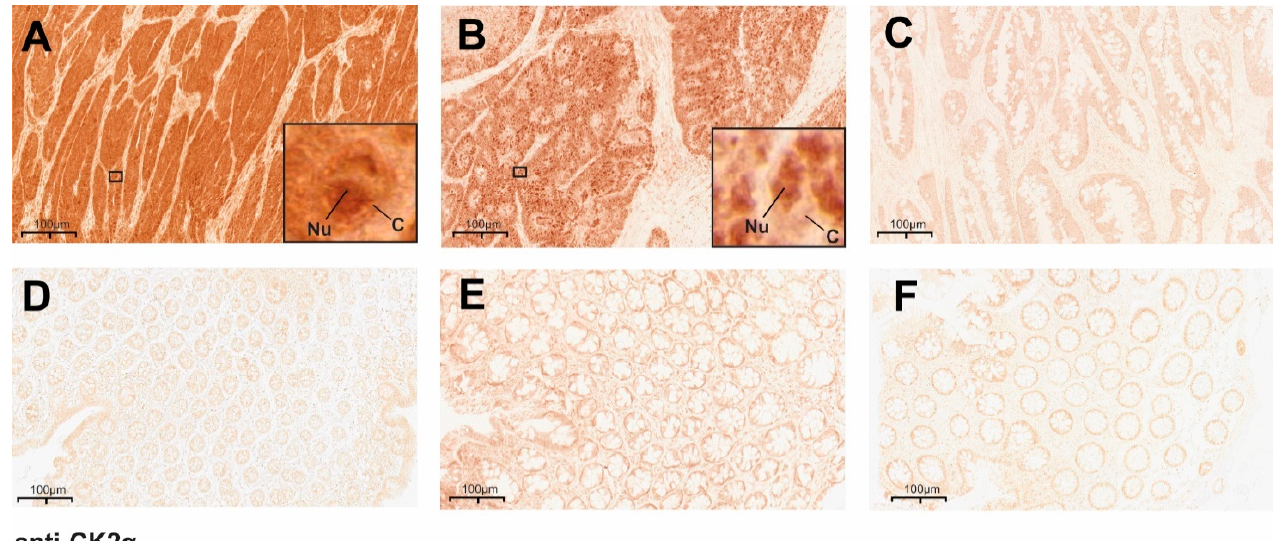
Figure 1. Immunohistochemical staining demonstrates significantly differential CK2 α expression in CRCs. Paraffin-embedded, invasively growing CRCs and corresponding surrounding normal mucosa was analyzed for CK2 α expression by immunohistochemical staining. Exemplarily shown are results of CK2 α expression in ( A – C ) different CRC tissues and ( D – F ) the respective corresponding normal mucosa. Three different types of CK2 α expression were detected: ( A , D ) CRC tissue shows very high nuclear/cytoplasmic CK2 α expression and normal mucosa shows low CK2 α level; ( B , E ) CRC tissue shows high nuclear CK2 α expression and normal mucosa shows low/moderate CK2 α level; ( C,F ) CRC tissue and normal mucosa both show comparable low nuclear/cytoplasmic CK2 α expression. Original images were captured at 10 ‐ fold magnification, and the areas outlined by a quadrangle ( A,B ) show the magnification of individual cells for better visualization. C: cytoplasm; Nu: nucleus.